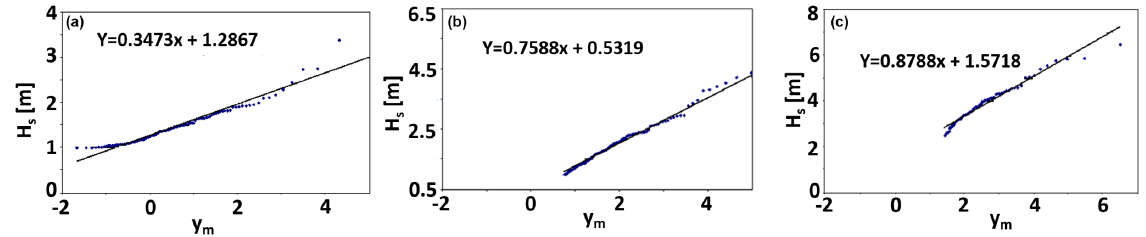
Figure 3. Matching between the recorded extreme wave heights and the reduced variable for the Gumbel distribution function for waves coming from (a) 135–195 ◦ N, (b) 195–225 ◦ N and (c) 225–260 ◦ N. The dataset is relative to the records of the La Spezia wave buoy in the period 1989–2009.